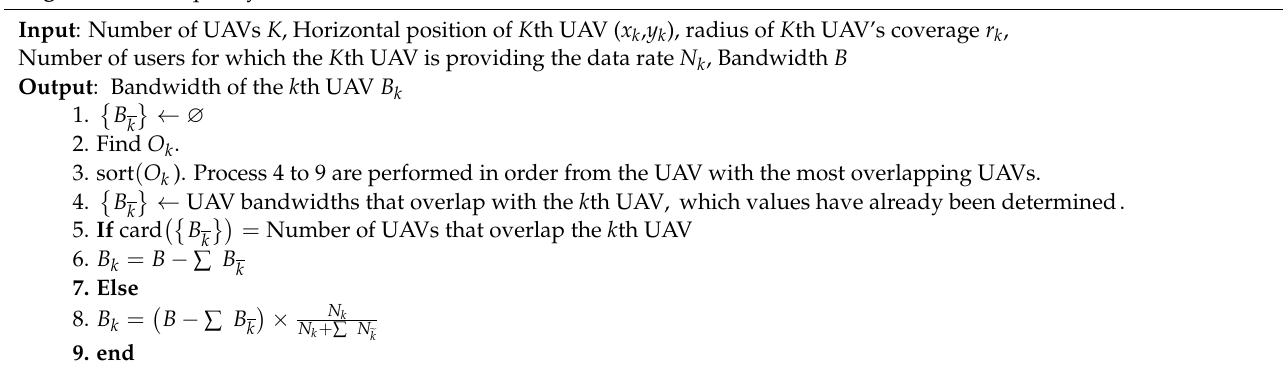
Algorithm 1: Frequency division for each UAV